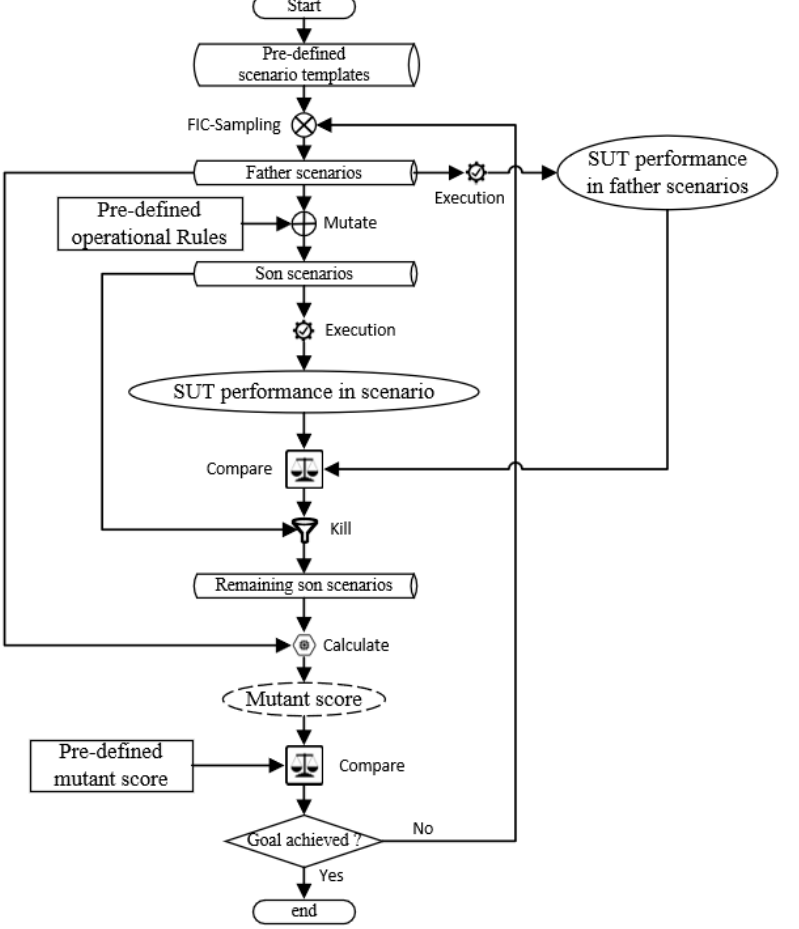
Figure 5. A flowchart of scenario generation based on MT [155]. “Father scenario” and “Son scenario” are terms used in this survey for